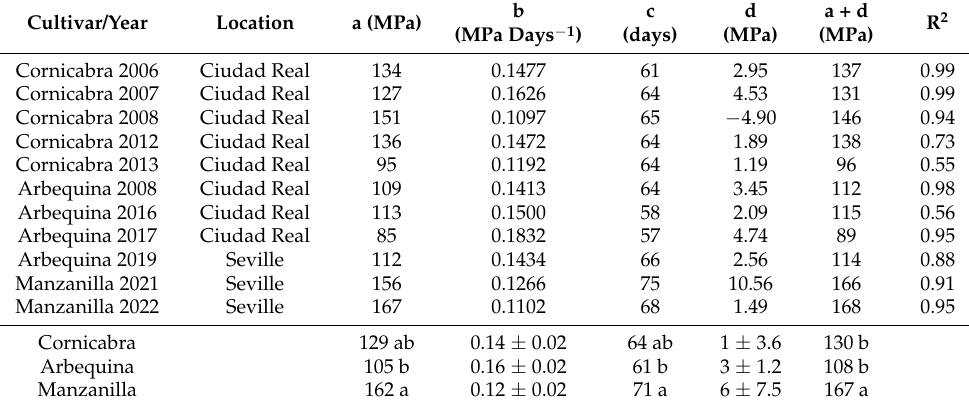
Table 1. Values of pit-breaking pressure (PBP) parameters and means and variability for the different varieties of measurement, according to the equation PBP = a same column mean significant differences between